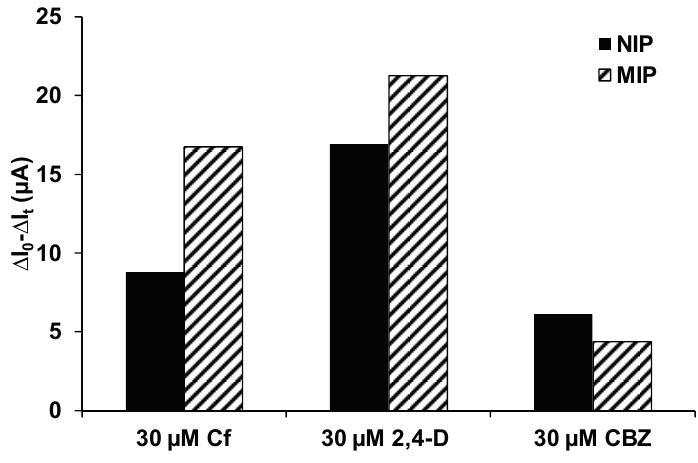
Figure 5. Selectivity test. PAD response of MIP and NIP prepared with 120 cycles (40 mM pyrrole) to 30 µM clofibric acid, 30 µM 2,4-D, and 30 µM